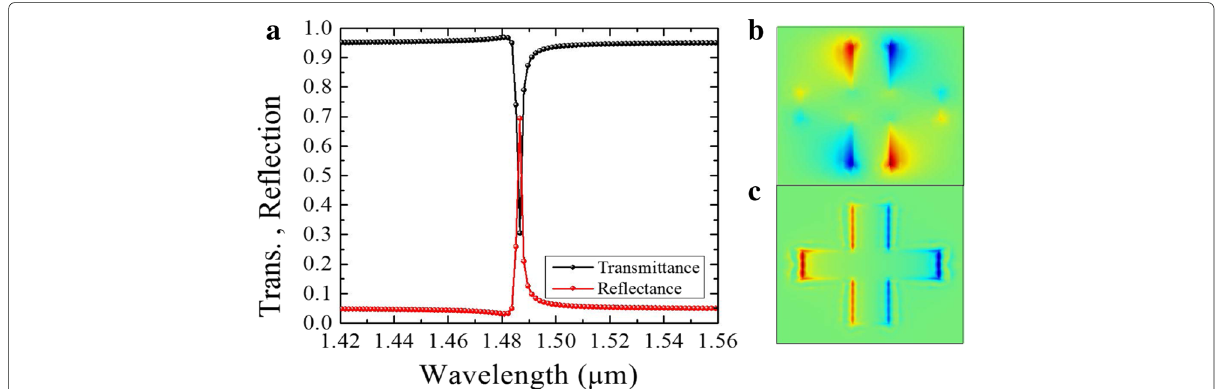
Fig. 2 a Transmission and reflection for the dielectric structure without graphene. b , c . In-plane electric fields E x (b) and E v (c), calculated at the resonance wavelength λ = 1.49 μ m